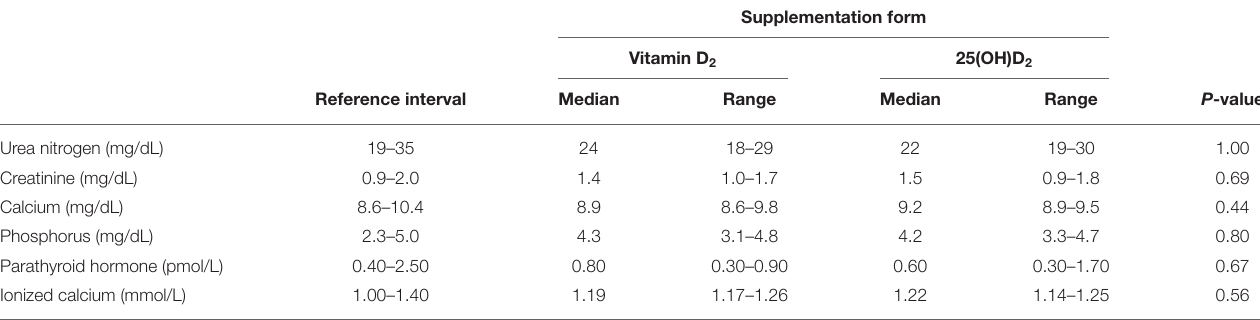
TABLE 3 | Median and range of select biochemistry and endocrinology variables in seven cats after 10 weeks of oral supplementation with vitamin D 2 or 25(OH)D 2 while consuming a commercial feline diet containing vitamin D 3